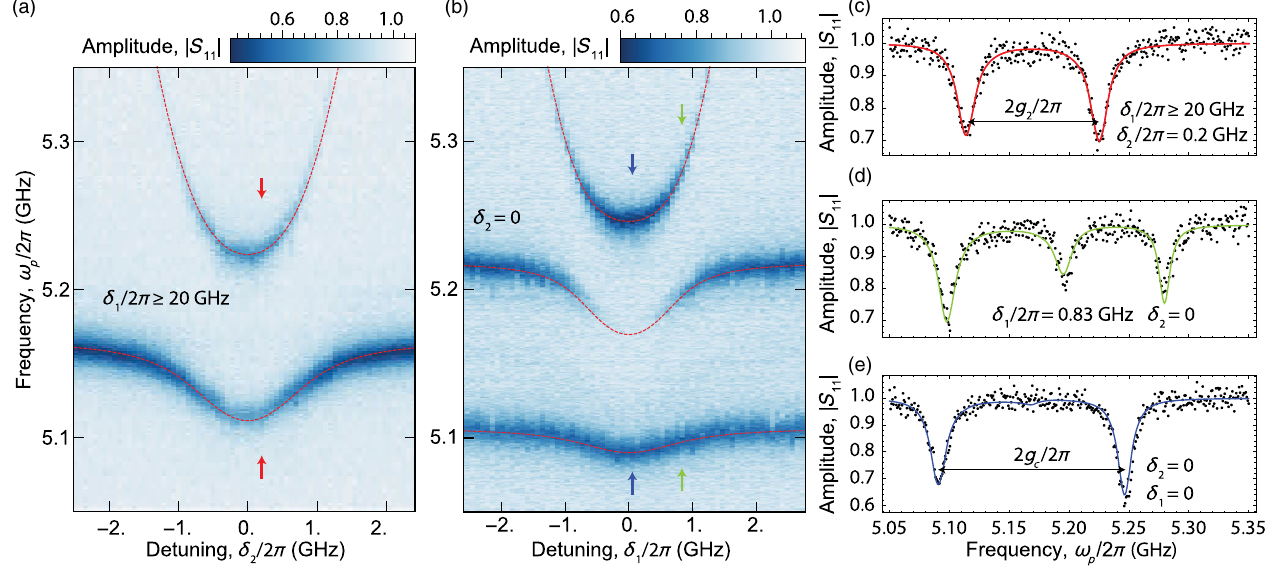
FIG. 7. Resonator spectroscopy with one or two DQDs tuned into resonance with the resonator. The same charge configuration is used for the data in Fig. 2 of the main text. (a) Tuning δ 2 of DQD 2 ( 2 t 2 = 2 π ¼ 5 . 168 GHz) into resonance with the SQUID array resonator, when DQD 1 is tuned in Coulomb blockade, δ 1 = 2 π ≳ 20 GHz. (b) With ω resonance by changing δ 1 . (c) – (e) are line traces of (a) and (b) to show the conditions ω ω ω (green arrows), and ω (blue arrows). All fits in (c) – (e) are fits to the master equation with extracted parameters listed r ¼ DQD 2 ¼ DQD 1 and discussed in Appendix